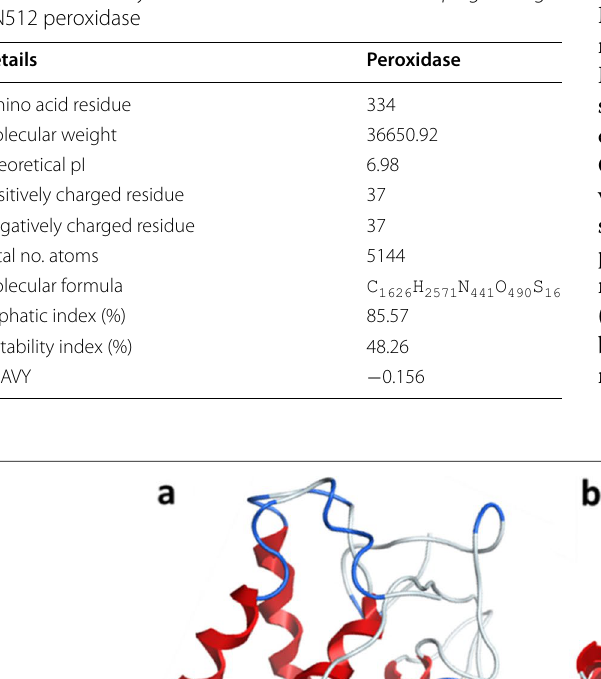
Table 3 Summary of the ProtParam data for the Aspergillus niger